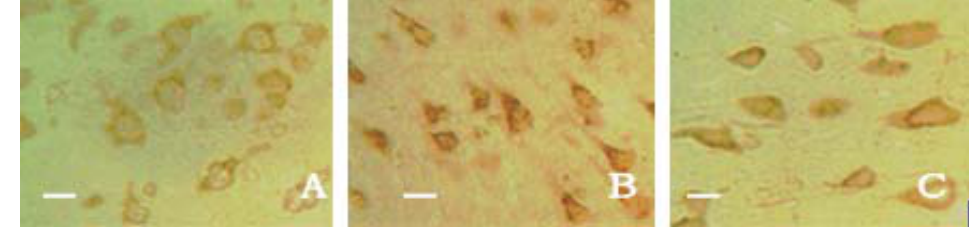
Figure 4. Caspase-3 positive cells in cortex shown by immunohistochemical assay × 400.